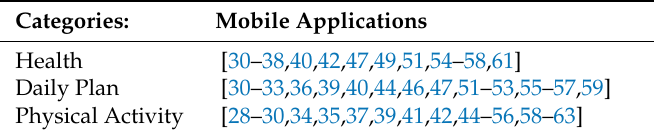
Table 6. Distribution of mobile application by categories of